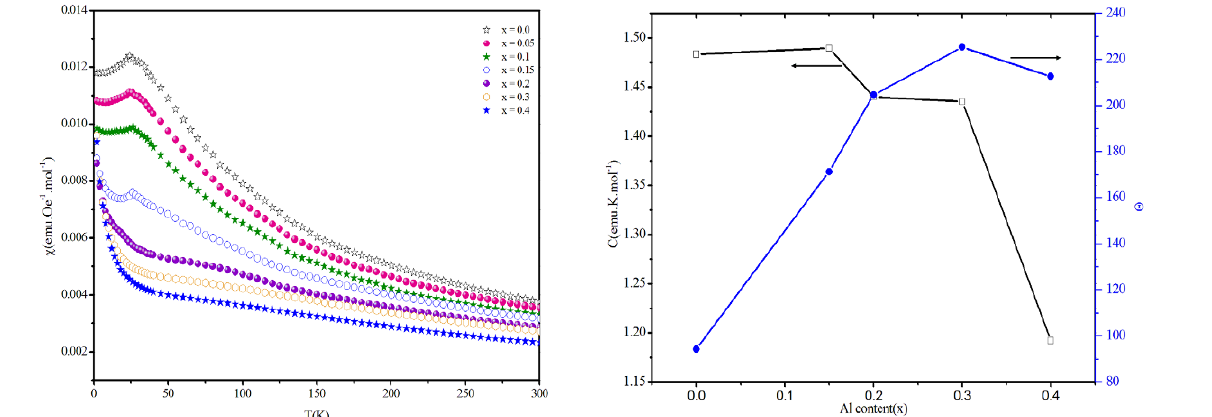
Figure 5. Temperature (T) dependence of the inverse susceptibility of CuCr Al O for 0 ≤ x ≤ 0.4 1-x x 2